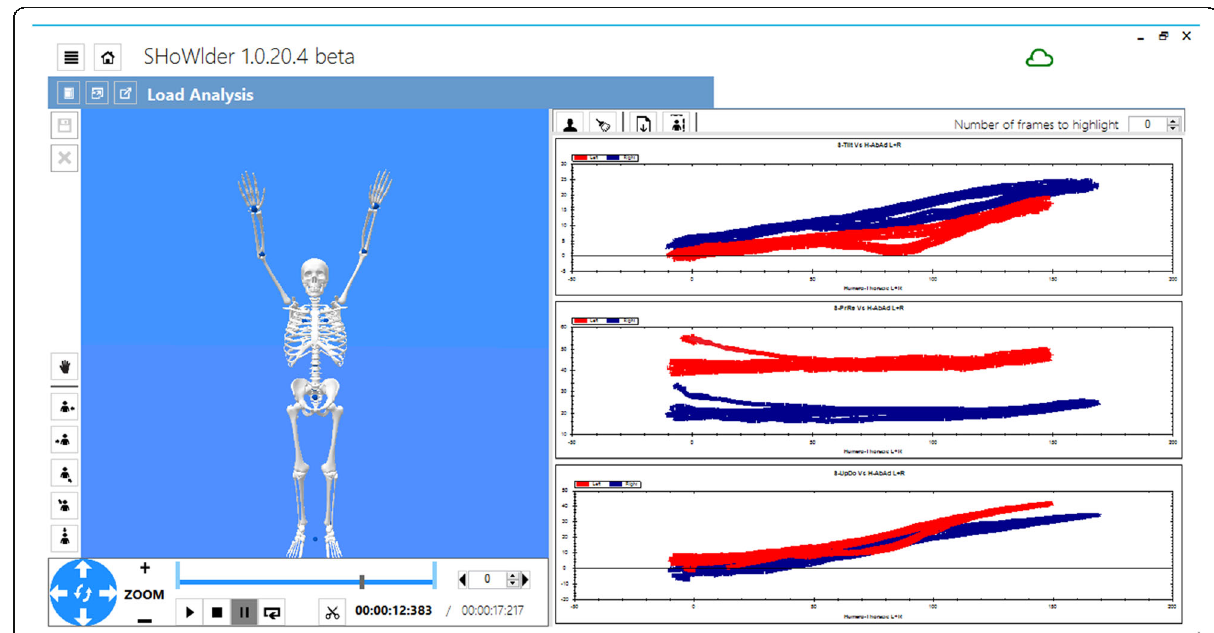
Fig. 2 The SHoW Motion graphical interface. It shows, in real time, the angular data obtained: on the left an avatar represents the movements of the subject and can be used to confirm proper tracking. On the right, the graphs related to the scapula-humeral rhythm are displayed, for both right (blue lines) and left shoulder (red